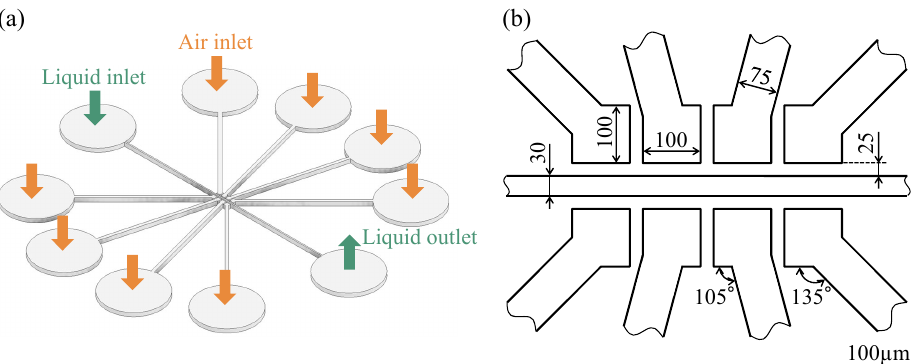
Figure 2. Sidewall-driven micropump: ( a ) overall view of the flow path; ( b ) dimensions of the sidewall-driven micropump.